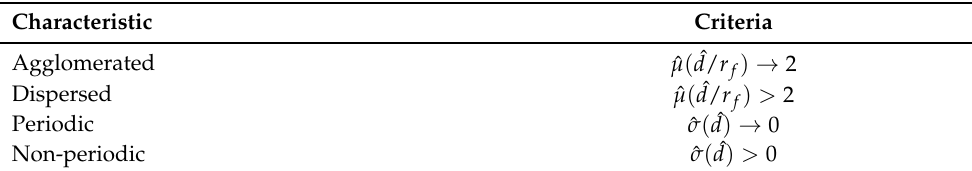
Table 1. Adopted criteria for quantitatively characterizing a fiber distribution using the nearest neighbor